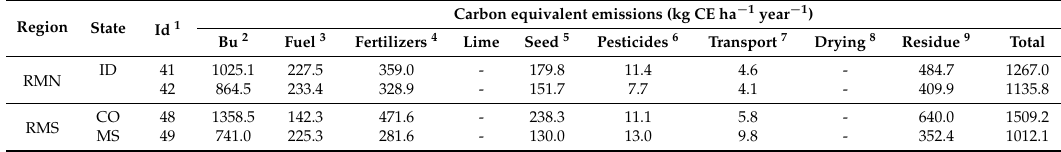
Table A4. Carbon equivalent emissions for potato systems in the United States. Region State